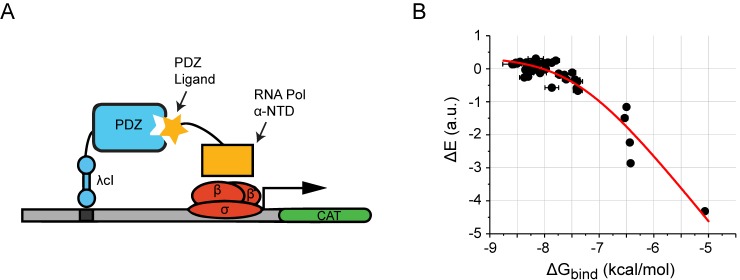
The bacterial two-hybrid assay for PDZ ligand binding.(A) The bacterial two-hybrid system consists of three parts, (1) a PDZ domain fused to the C-terminus of a λ-cI DNA binding domain, (2) a ligand peptide as a C-terminal fusion to the α-subunit of RNA polymerase, and (3) a reporter plasmid encoding chloramphenicol acetyltransferase (CAT). Ligand binding induces transcription of the reporter gene, which enables growth in the presence of the antibiotic chloramphenicol. (B) Binding free energies for 45 PSD95pdz3 single mutants plotted against the relative enrichment values ΔE derived from deep sequencing before and after selection (see Supplementary Methods). Horizontal bars around each point represent the range of values from replicate binding experiments, and the red curve represents a fit to a model in which the relative enrichment is proportional to the log fraction bound of ligand (ΔE∝ln⁡fB, see Supplementary Methods). Parameters of the assay (inductions conditions, temperature, length of growth, promoter structure) are optimized such relative enrichment values quantitatively report the binding free energy (fit shows an adjusted r2=0.91).